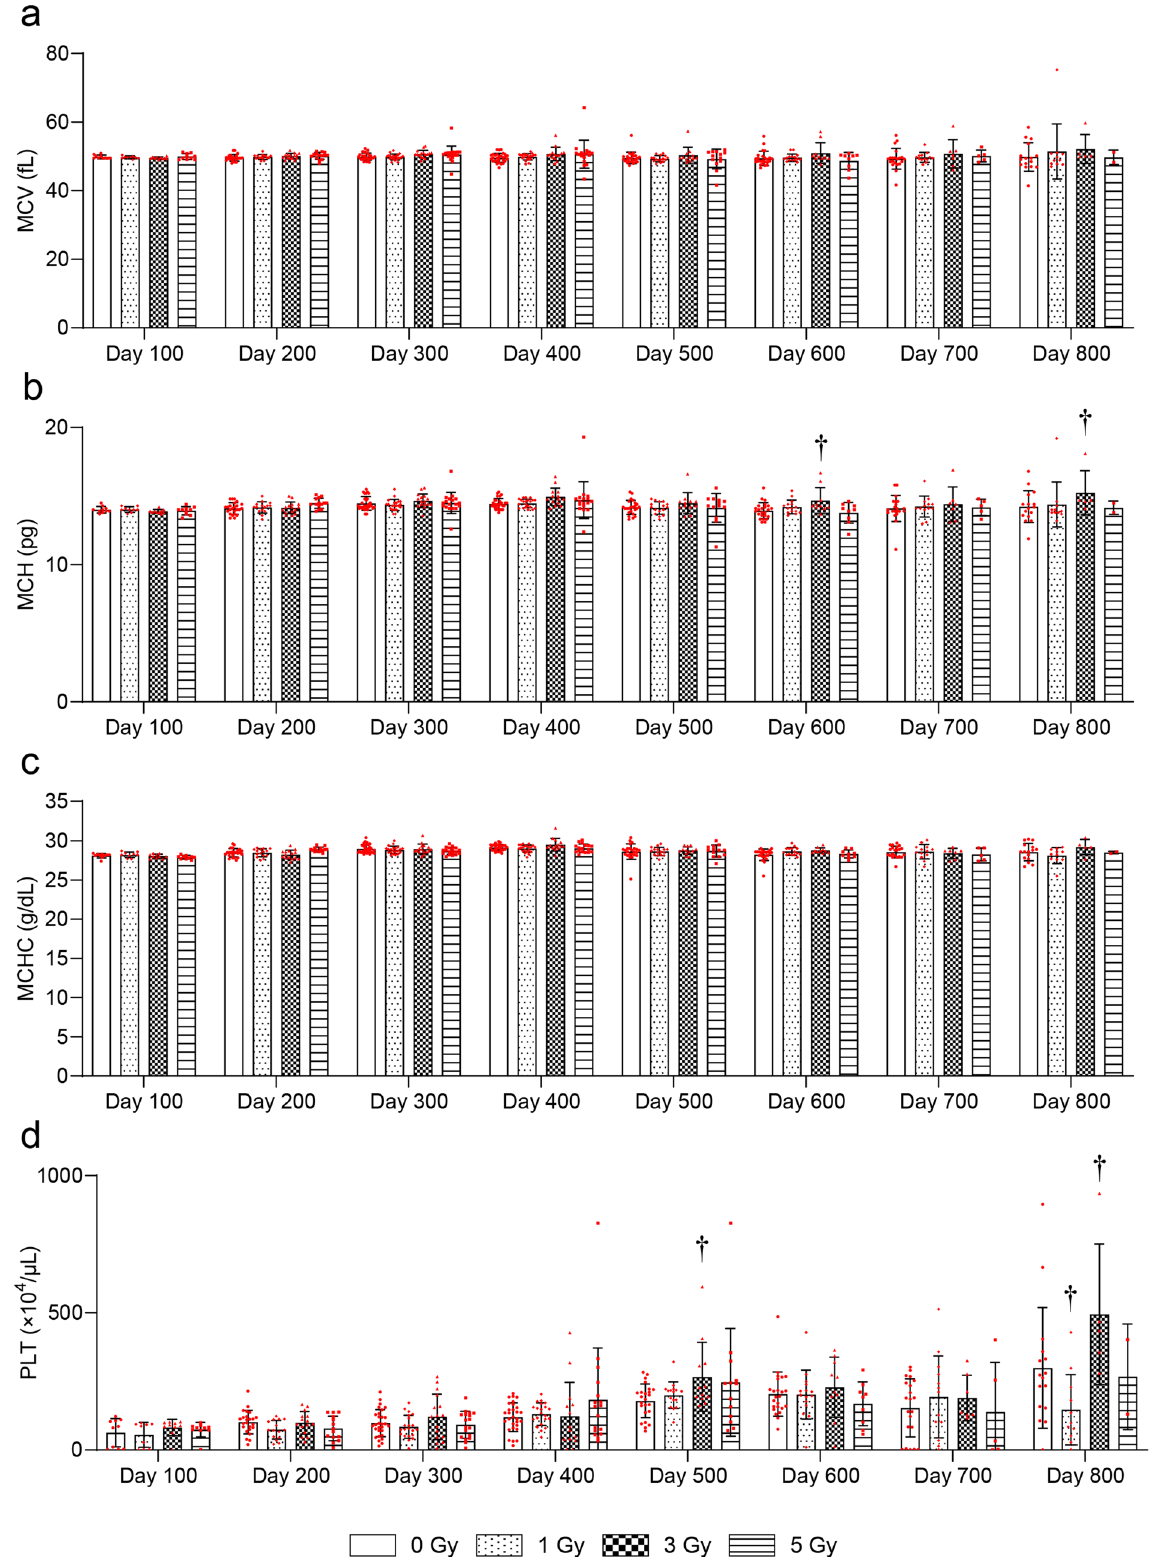
Figure 4. Changes in CBC more than 100 days after TBI. Changes in ( a ) mean corpuscular volume (MCV), ( b ) mean corpuscular hemoglobin (MCH), ( c ) mean corpuscular hemoglobin concentration (MCHC), and ( d ) platelets (PLT). Bars indicate the means, error bars indicate the SDs, and red dots indicate individual data points. Two-way ANOVA and the post hoc Dunnett’s test were used to analyze significant differences with the 0-Gy group. † Indicates P <